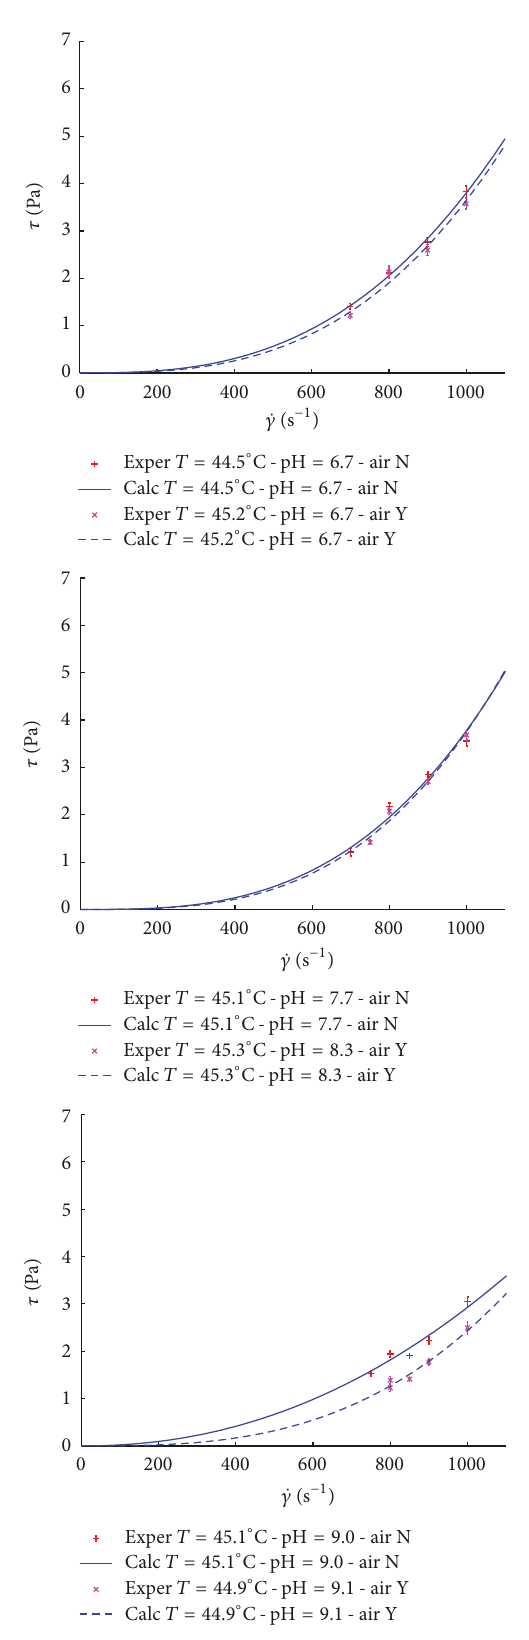
Figure 8: Shear stress versus rate of deformation (MLSS 150 gL −1 ): comparison between experimental and calculated